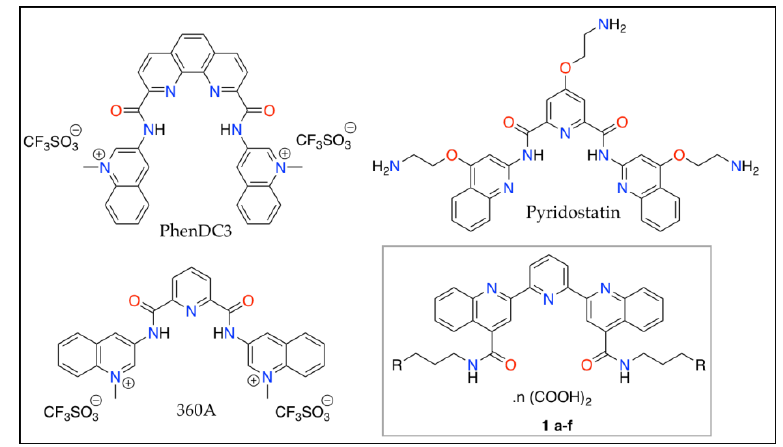
Figure 1. The structures of Phen-DC3, pyridostatin, 360A and newly designed 2,6-di-(4-carbamoyl-2- quinolyl)pyridine derivatives 1a – f .